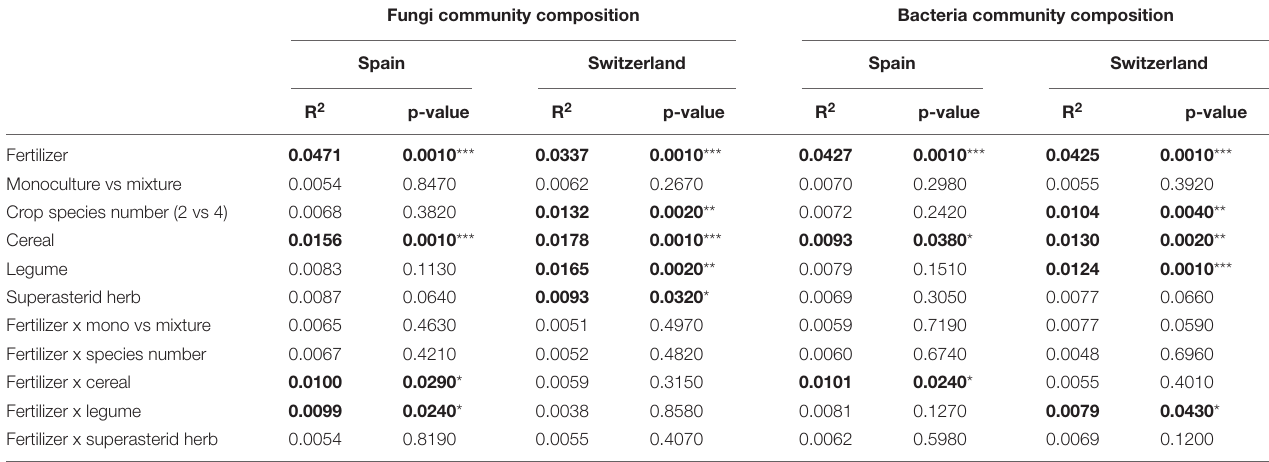
TABLE 2 | Results of the permutational analysis of variance, showing R 2 and significance of the considered factors for the community composition of fungi and bacteria in Spain and Switzerland. Fungi community